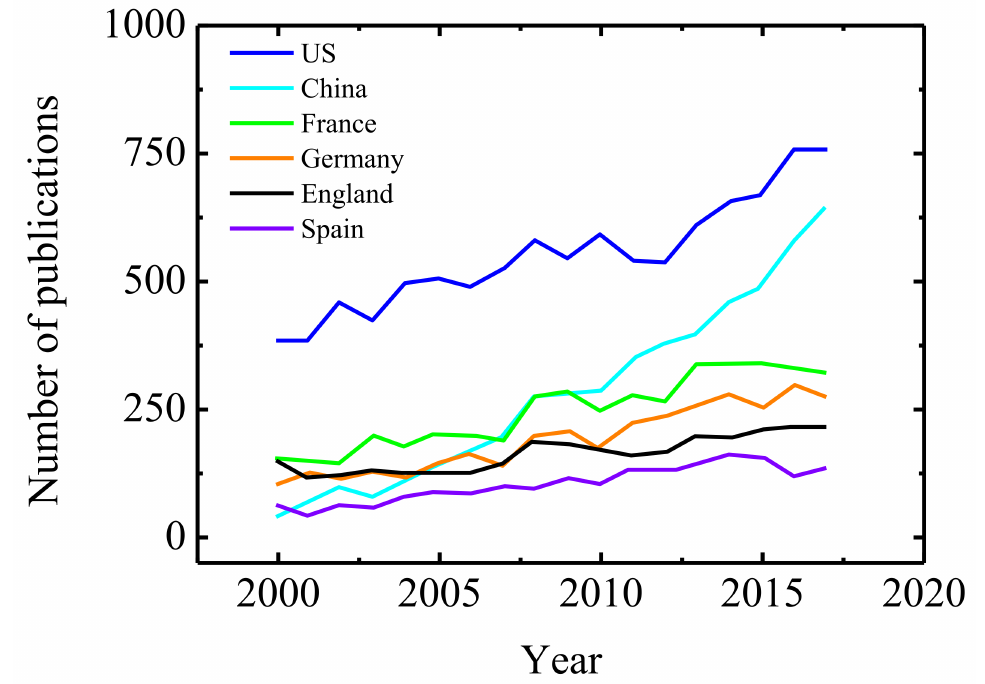
Figure 1. Number of publications on rheology for US, China, France, Germany, England, and Spain from 2000 to 2017. Taken from reference